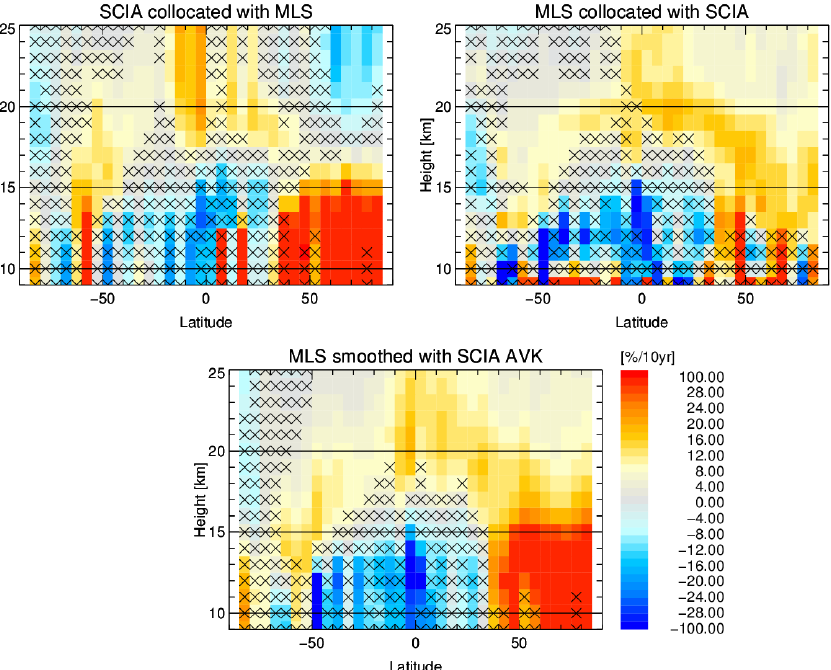
Figure 20. Linear trend for zonal monthly mean collocated data from SCIAMACHY and MLS (unsmoothed and smoothed with SCIA- MACHY AVKs). Collocations are found between August 2004 and March